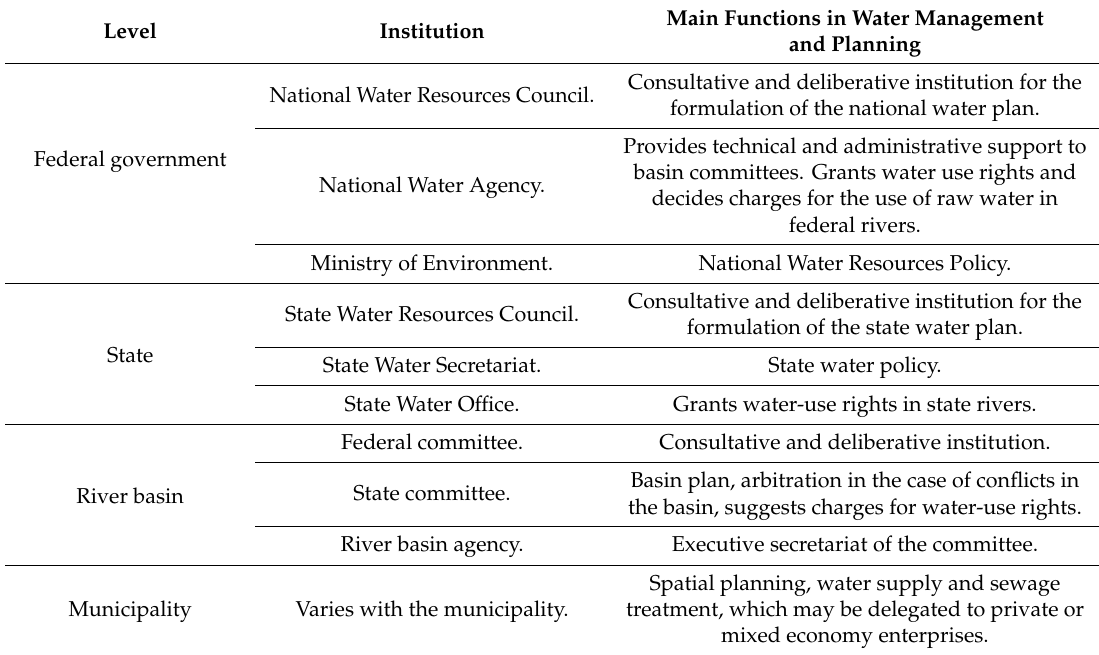
Table 2. The main institutions and functions in water management and planning in